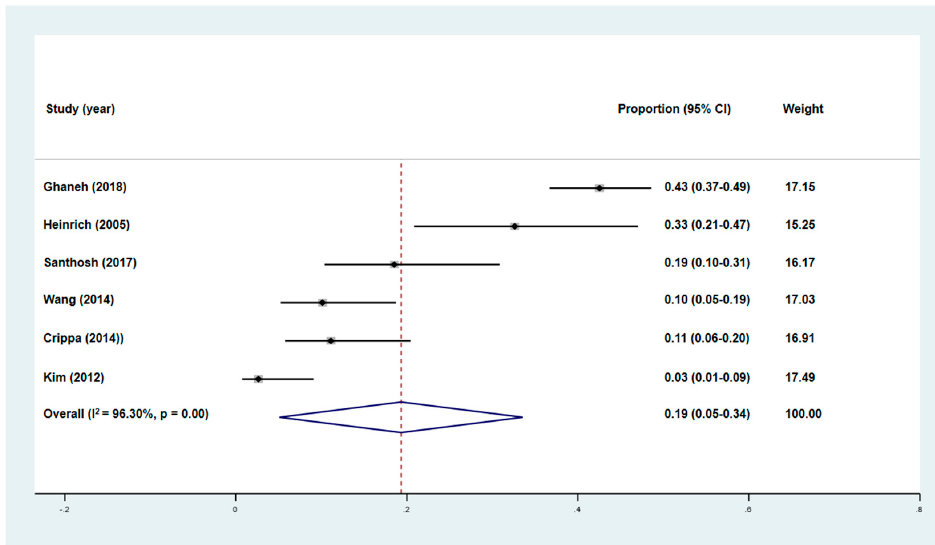
Figure 5. Forest plot of the pooled proportion of patients who underwent management changes after FDG PET / CR and PET / MRI, with 95% confidence intervals. Each solid square represents the proportion of patients who underwent management changes in each individual study, while the diamond represents the pooled